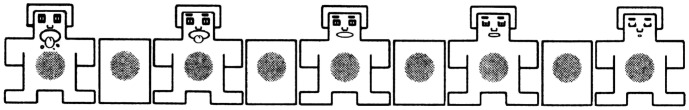
SAM food craving scale.Initially developed to assess tobacco craving [32], the SAM food craving scale ranges from a drooling to a mouth-shut SAM.